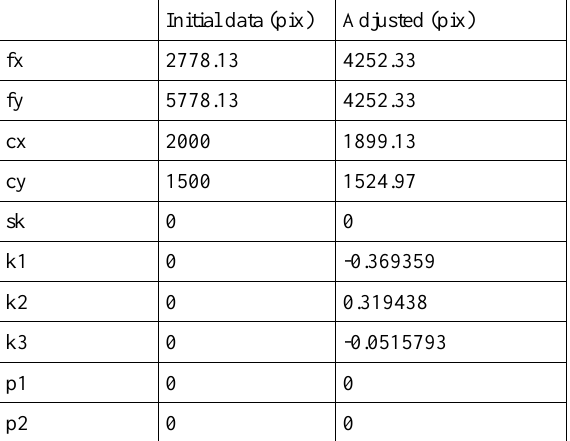
Table 7. Intova calibration parameters